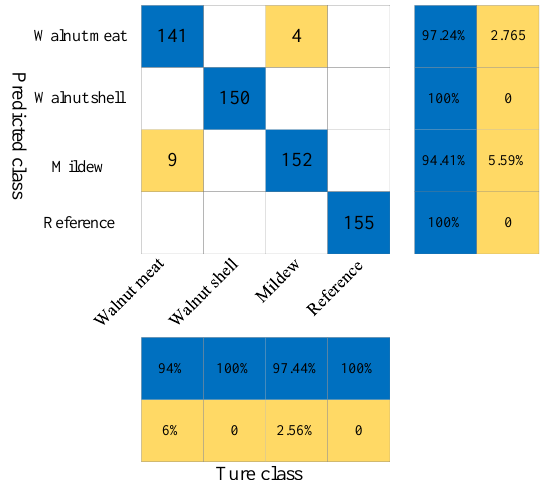
Figure 8. The confusion matrix of prediction results of walnut shell, walnut kernel, mildew sample and reference signal under KNN model.